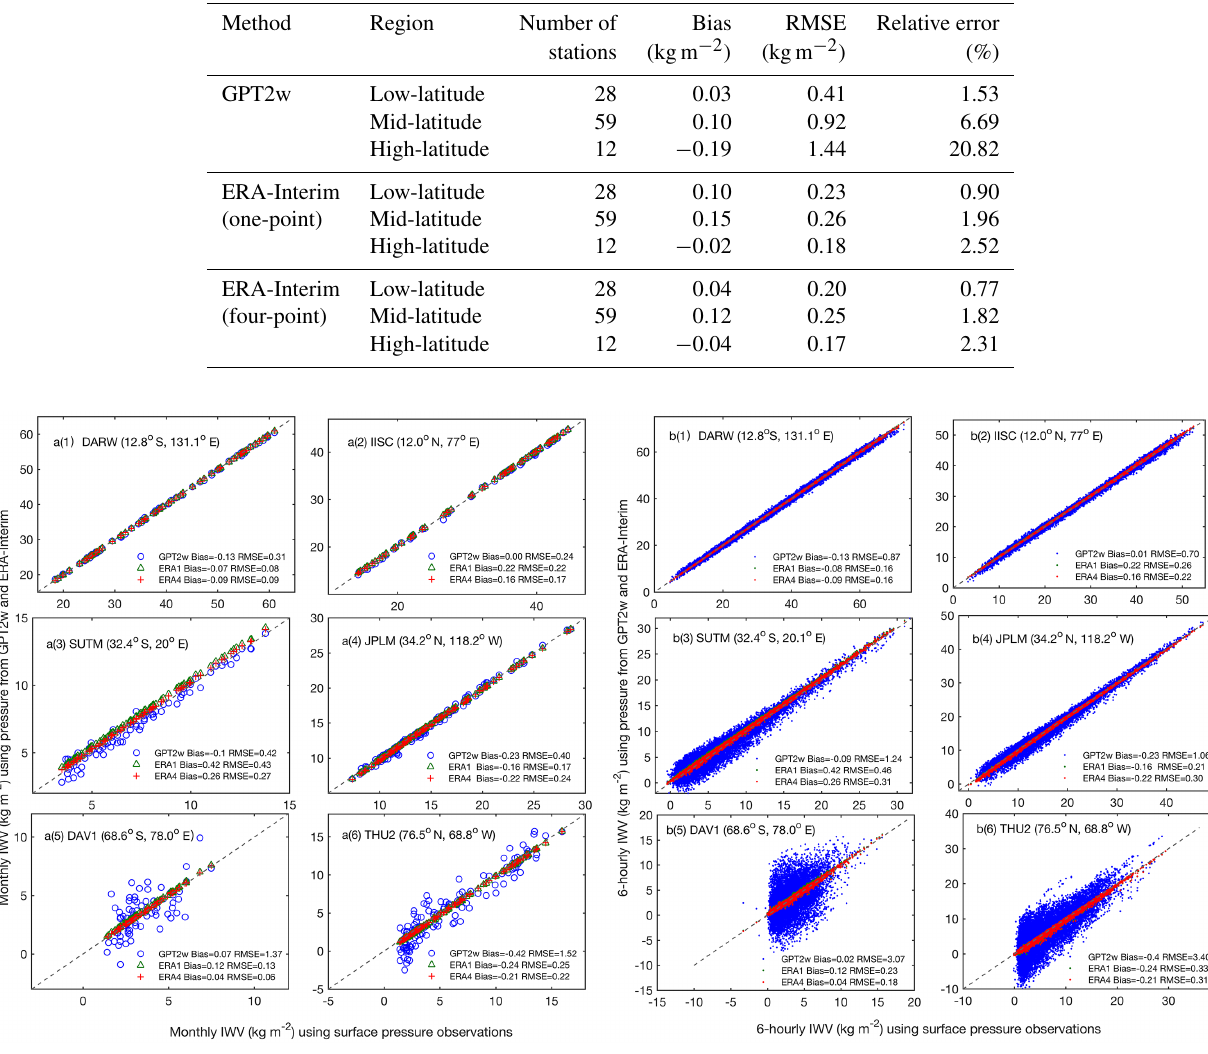
Figure 4. Scatter plots of the monthly mean of IWV (a1–a6) and 6h IWV (b1–b6) determined using surface pressure observations ( x axis) and IWV determined using pressure from GPT2w and ERA-Interim ( y axis) for the period of 2000–2013 (ZTD from CODE is used in the computation of